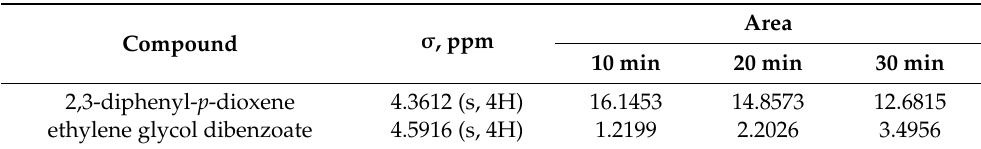
Table 3. Characteristic values of chemical shifts for individual compounds and areas under the peaks after the specified irradiation time assigned from 1 H NMR spectra.